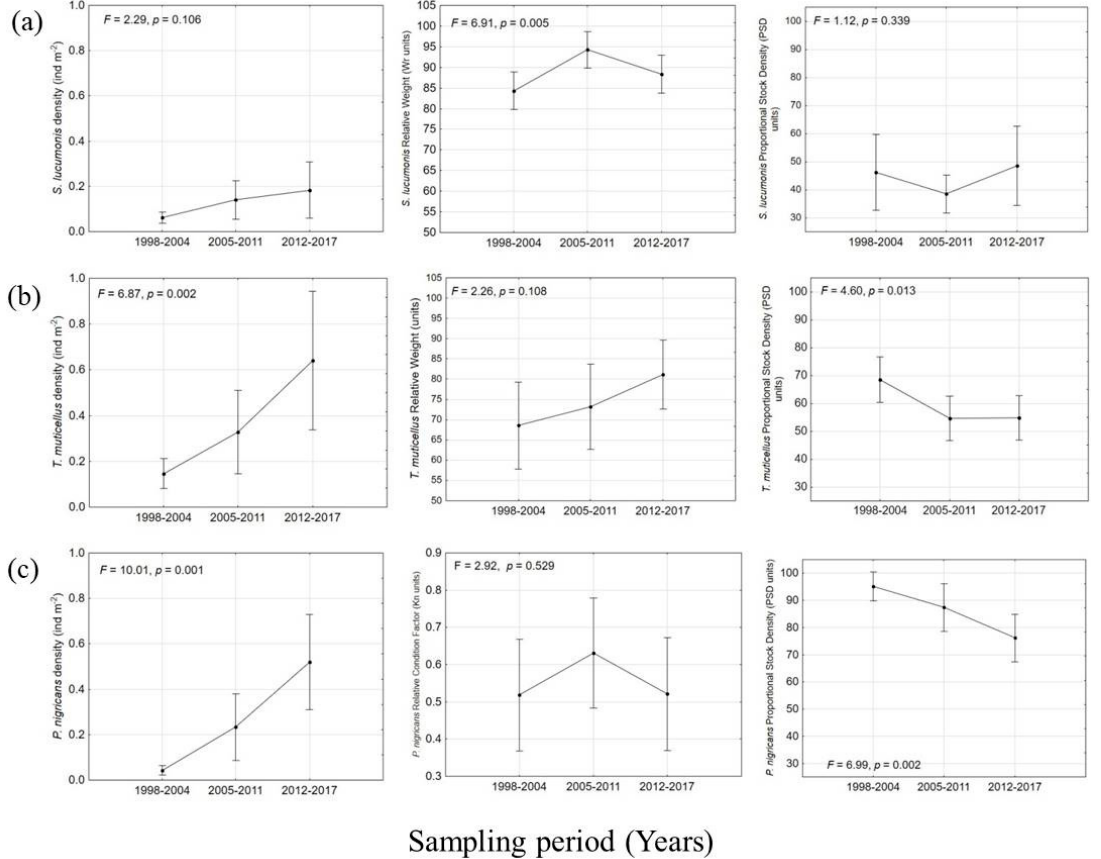
Figure 10. Trend over time of the mean density, relative weight (Wr), and proportional stock density (PSD) values for: ( a ) Squalius lucumonis , ( b ) Telestes muticellus and ( c ) Padogobius nigricans , for the sampling periods 1998–2004, 2005–2011, 2012–2017. Vertical bars denote 0.95 confidence intervals. Note the different Kn scale values compared to Wr.